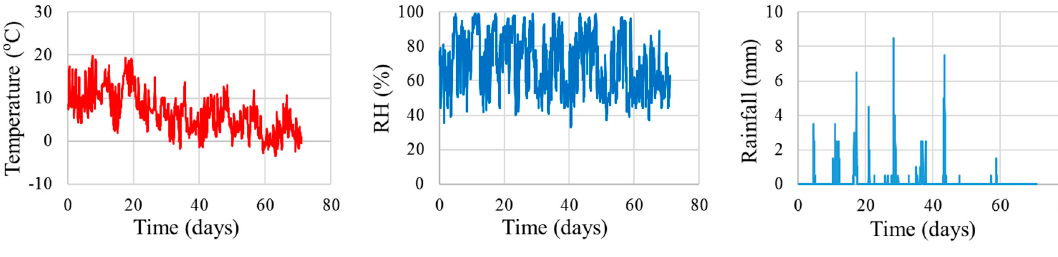
Figure 15. Environmental conditions.